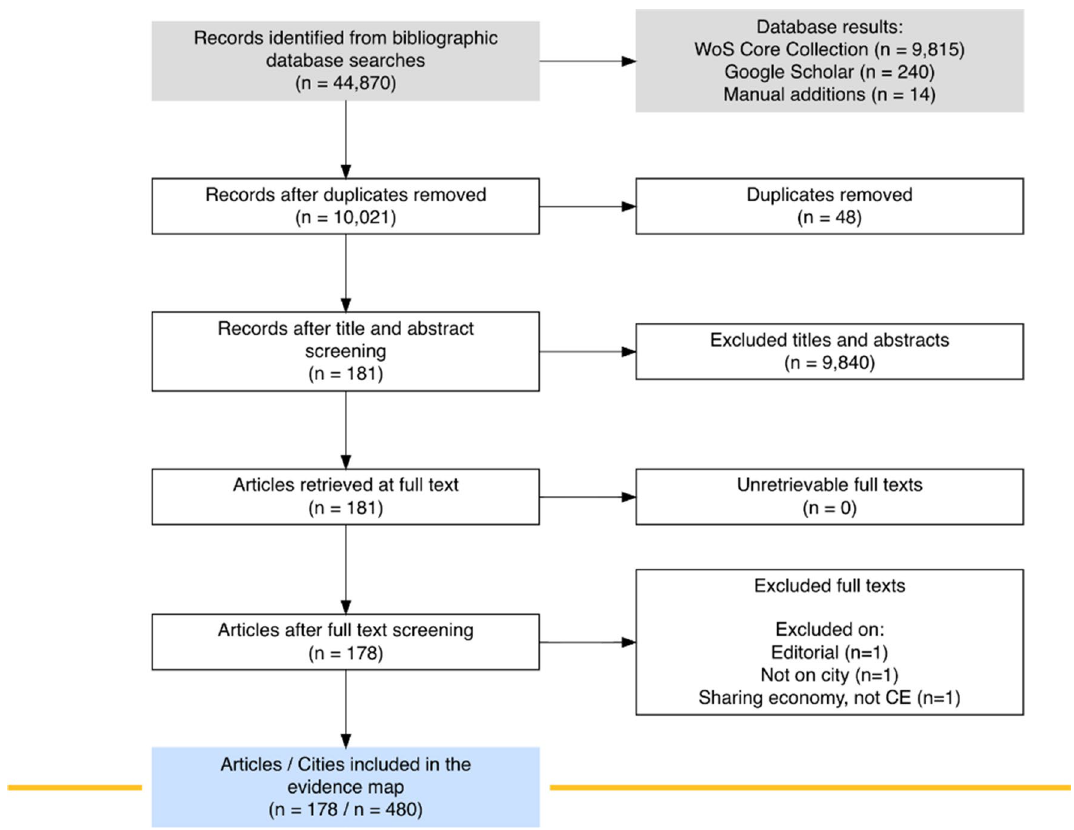
Fig. 1 PRISMA flow diagram illustrating the search results and the articles excluded or included at each stage of the review